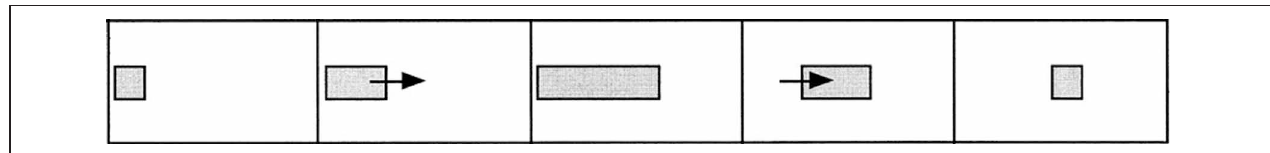
FIGURE 2 | Michotte’s (1963) caterpillar stimulus. The square appears to move itself by first rhythmically expanding from the right edge, then contracting from the left